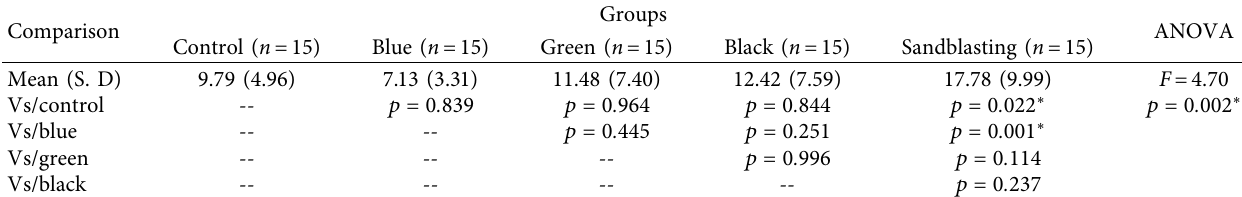
Table 2: One-way ANOVA for mean comparison of shear bond strength (MPa) among the groups.